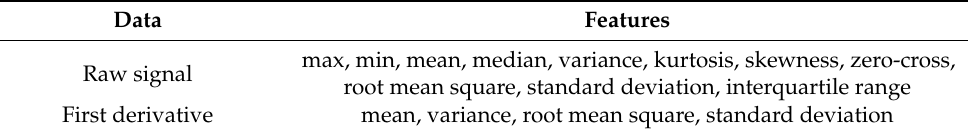
Table 1. Shallow features extracted from acceleration data.